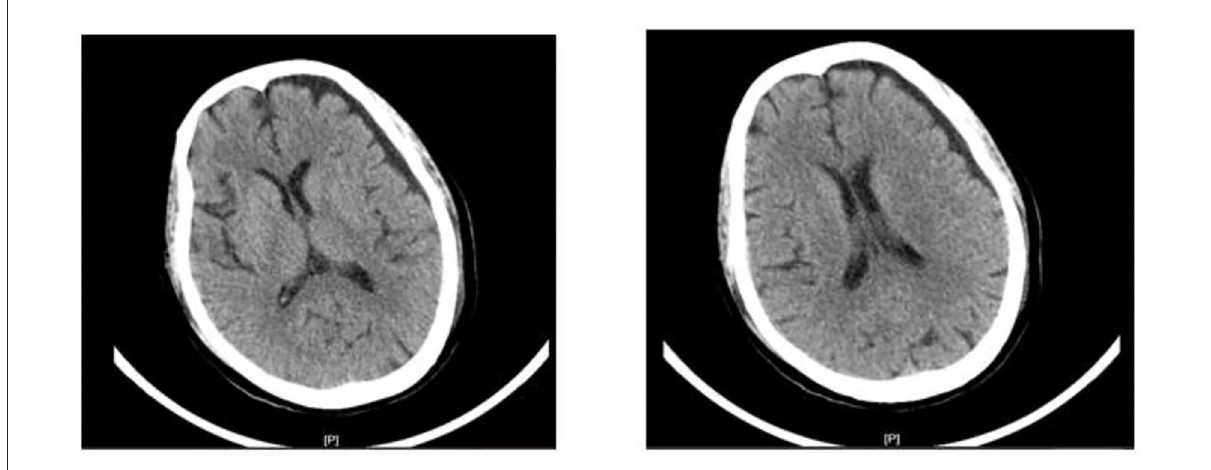
FIGURE1 The computed tomography image of the brain on day 12.